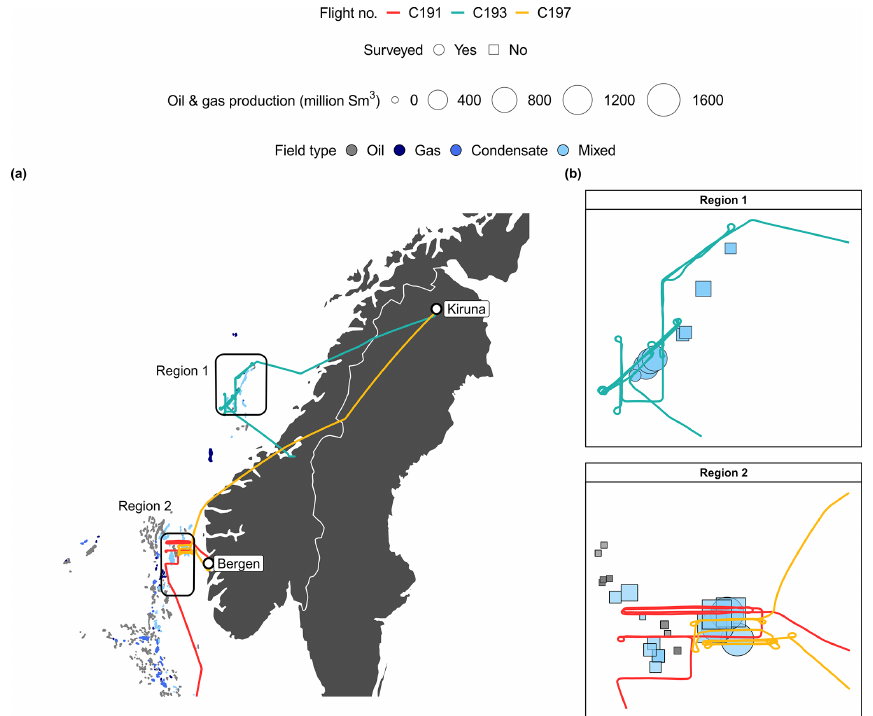
Figure 1. (a) Location of offshore fields on the Norwegian continental shelf and FAAM aircraft survey patterns (as coloured tracks). Each data point represents an offshore field, coloured by extraction product type (oil, gas, condensate or mixed). (b) Map of the FAAM flight tracks and locations of active O&G facilities in the two target regions. Each data point represents a distinct facility, sized according to the reported annual O&G production in 2019 (Norwegian Petroleum Directorate, 2021), with circles denoting facilities surveyed in this study. Sm 3 refers to standard cubic